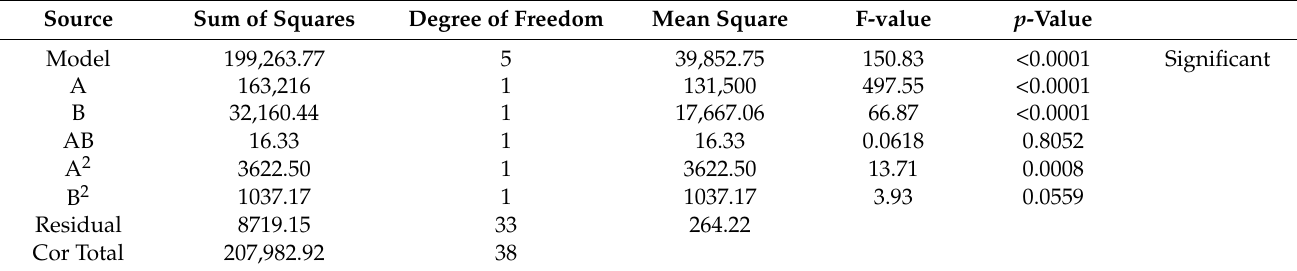
Table 5. ANOVA analysis for